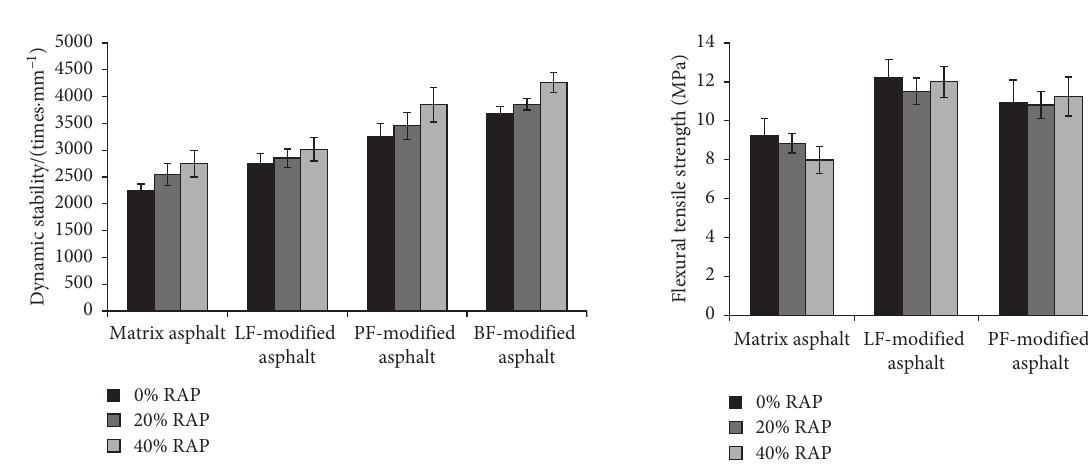
Figure 3: Dynamic stability results of different asphalt mixtures.